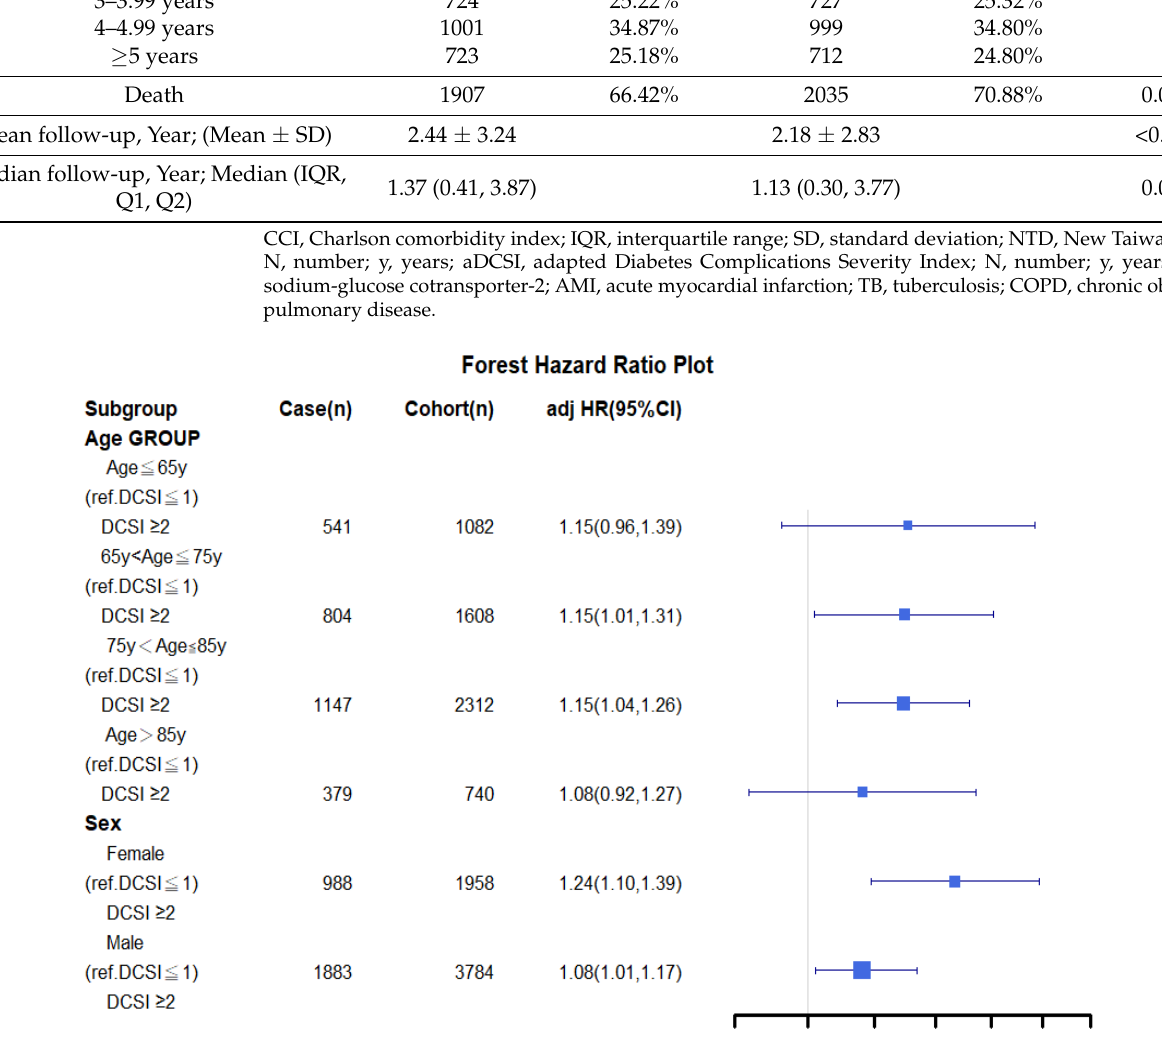
Table 2. Multivariable Cox proportional regression analysis of all-cause death among propensity score – matched patients with both lung squamous cell carcinoma and mild or moderate-to-severe diabetes.